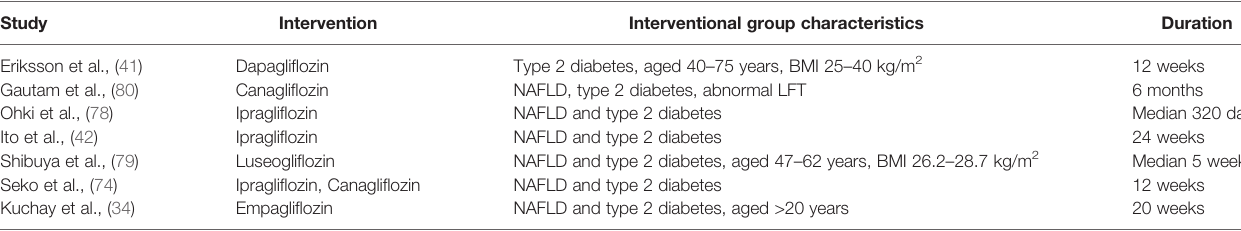
TABLE 2 | Intervention, interventional group characteristics, and duration of studies exploring the ef fi cacy of SGLT-2 inhibitors in patients with concurrent type 2 diabetes mellitus and non-alcoholic fatty liver disease.